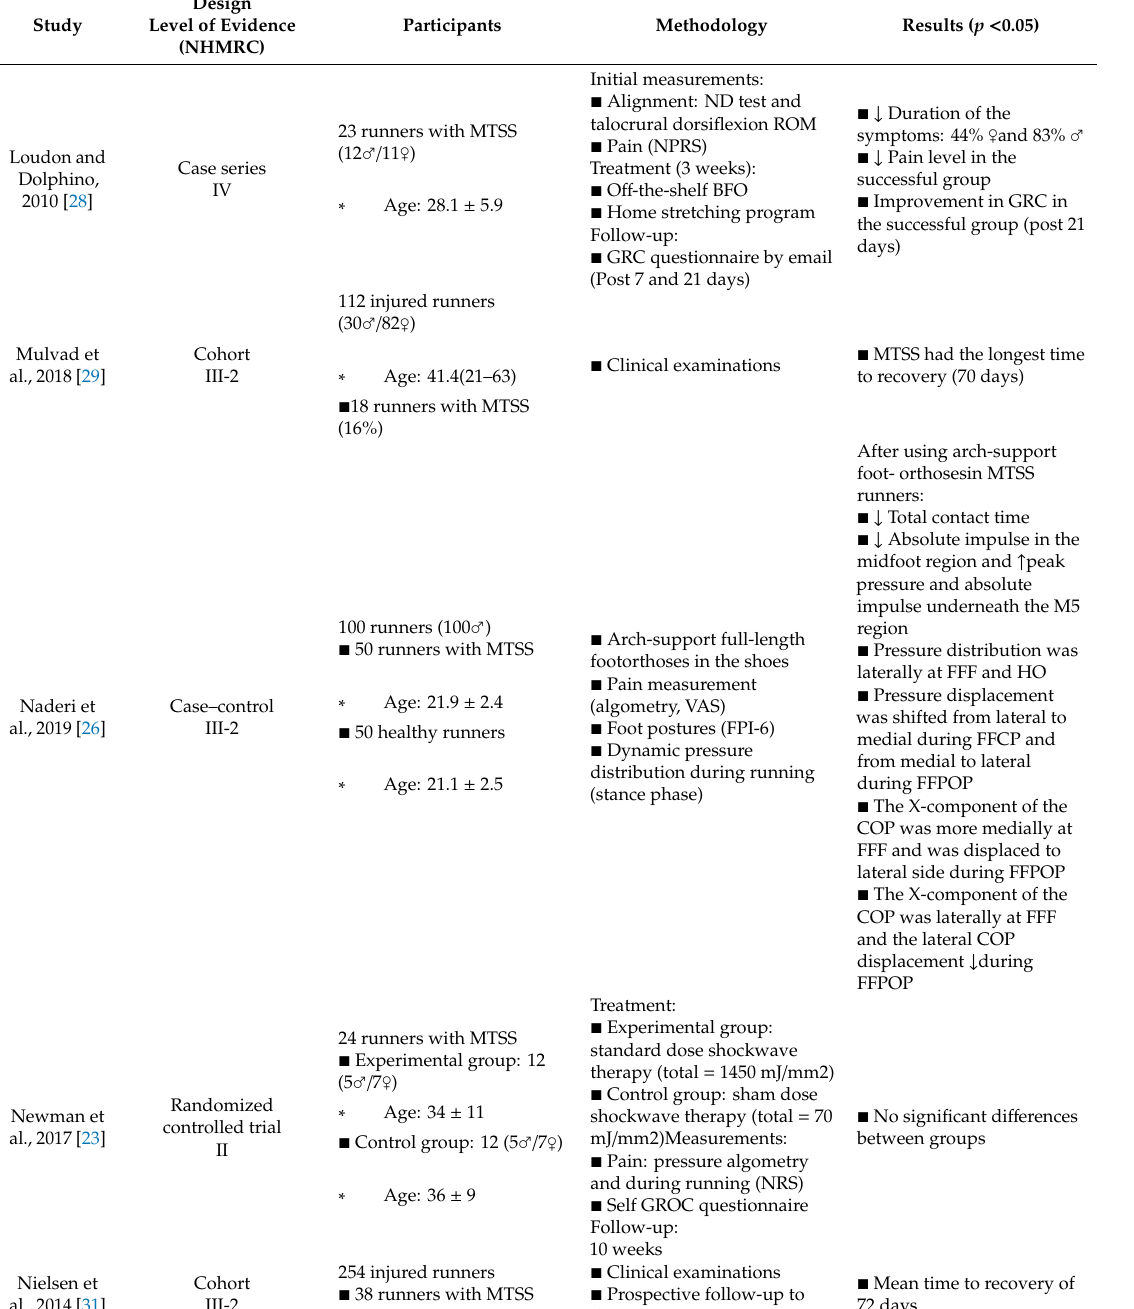
Table 6. Summary of studies analyzing treatment methods and time to